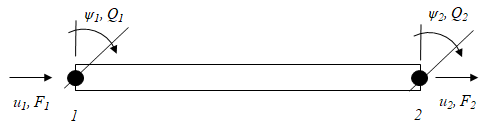
Figure 3. Two nodes Mindlin-Herrmann